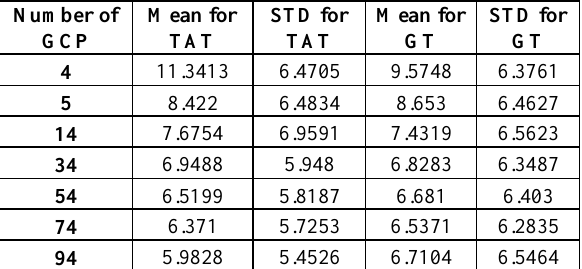
Table 1. The mean and standard deviation for TAT and GT after 100 runs of the check point.